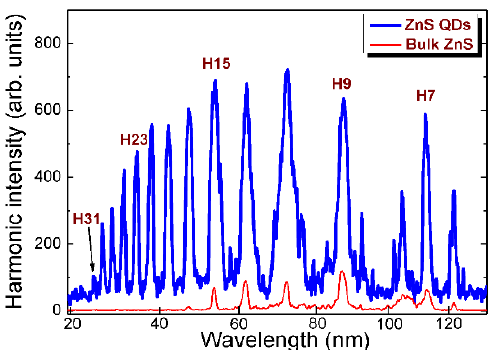
Figure 12. Harmonic distributions during propagation of DP through the plasmas produced on the bulk ZnS (red curve) and ZnS QD (blue curve) targets. Reprinted with permission from Ref. [43], 2018, Optica Publishing Group.